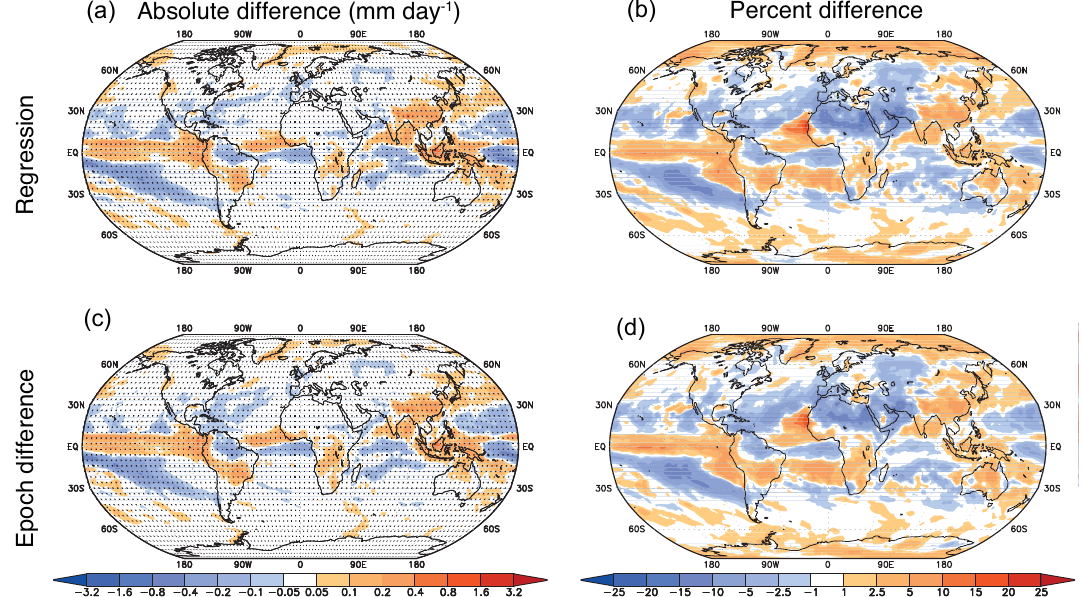
Figure 6. As in Fig. 3 but where the reconstruction ˆ B is built on the pattern P for the RCP8.5 simulation (group 1 average over years 227–251), and global mean temperature (cid:49) ¯ T is averaged over years 227–251 (2076–2100) of the RCP8.5 simulation; i.e., ˆ B = P RCP8 . 5 ( x )(cid:49) ¯ T RCP8 . 5 (227–251). Results shown are for the difference between the reconstruction and the actual model output of the RCP8.5 simulation ˆ B − B RCP8 . 5 ( x ,